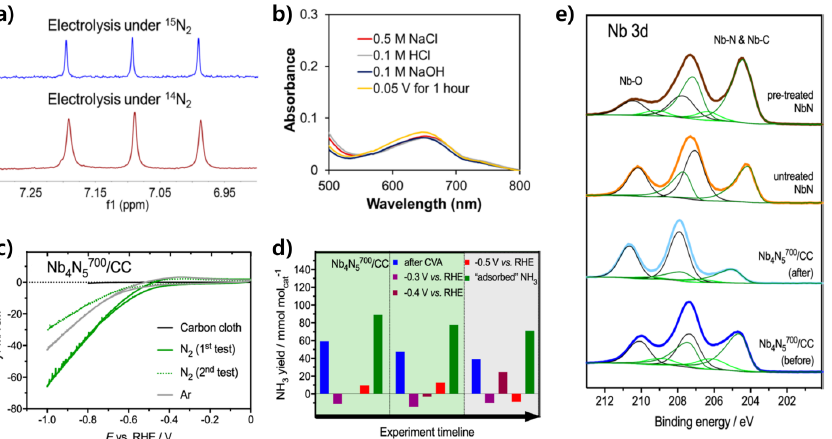
Figure 7. ( a ) 1 H NMR spectra of 14 N 2 and 15 N 2 on Mo 2 N. ( b ) Quanti fi cation of ammonia after incu- bating Mo 2 N in acidic, neutral, and alkaline solutions without and with a bias for 1 h. ( c ) J-V curves on Nb 4 N 5 /CC in consecutive tests (1st—N 2 , 2nd—N 2 , 3rd—Ar). ( d ) Changes of produced NH 3 for 3 times of consecutive tests. ( e ) XPS spectra in the Nb 3d region. Reproduced with permission from the American Chemistry Society [86,88].